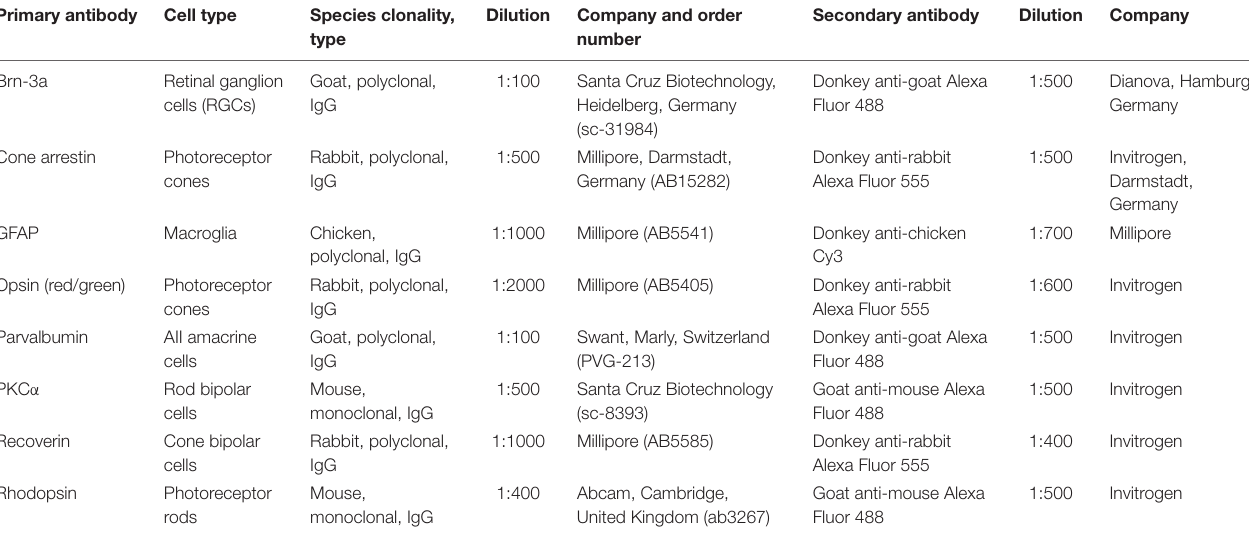
TABLE 1 | List of used primary and secondary antibodies, including cell type, dilution, and